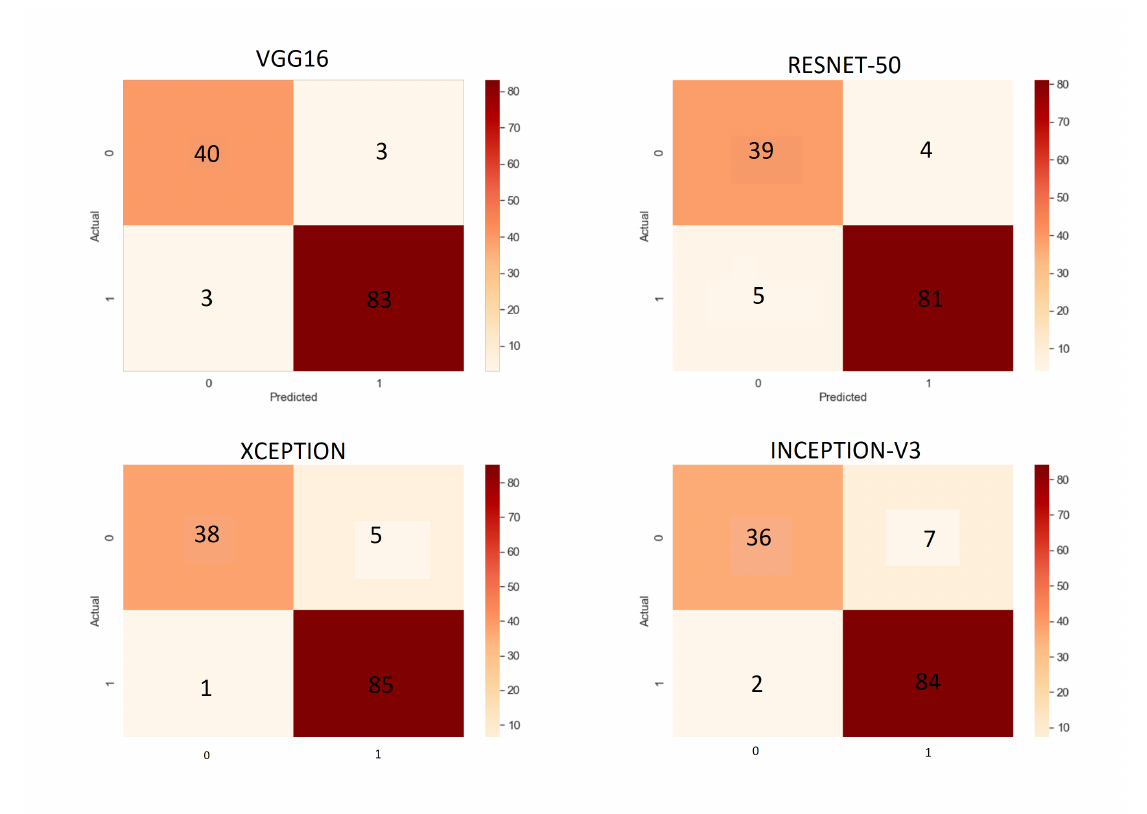
Figure 9. Confusion matrices for all base learners.